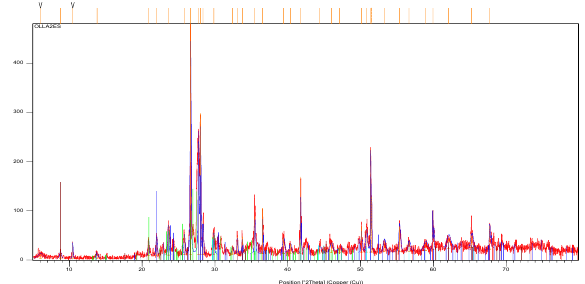
Figure 7. Mineral composition example for the 5 check point in the Turrialba volcano,